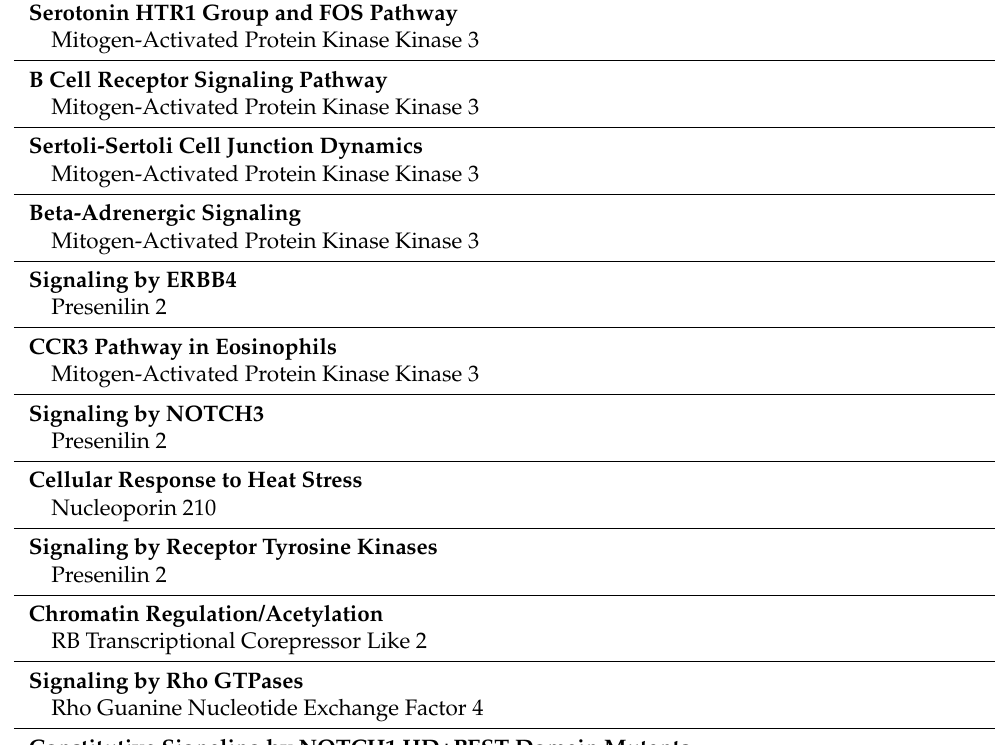
Table A2. Cont. Serotonin HTR1 Group and FOS